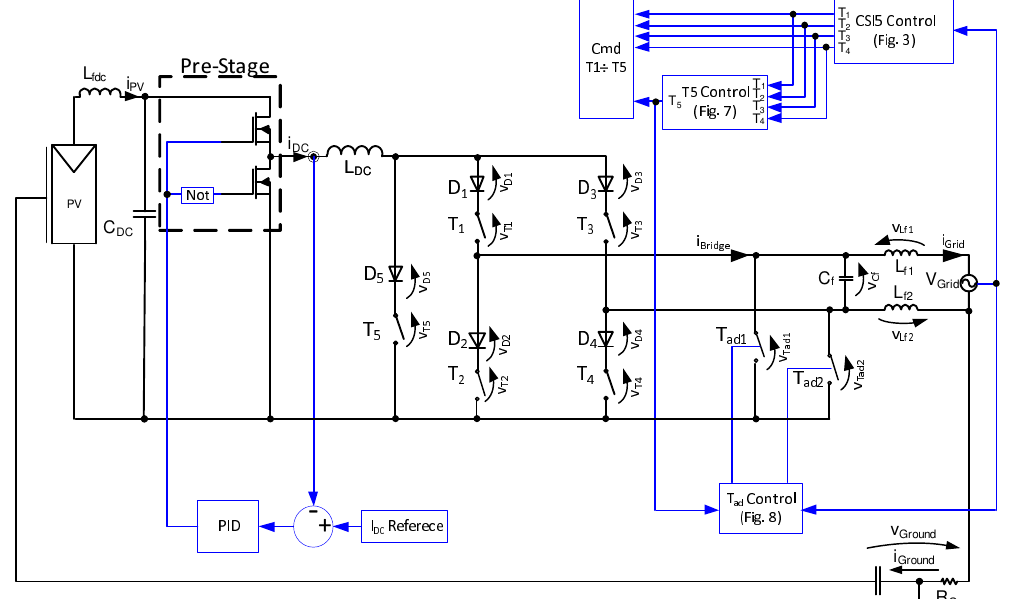
Figure 11. Schematic of the proposed CSI5 topology and